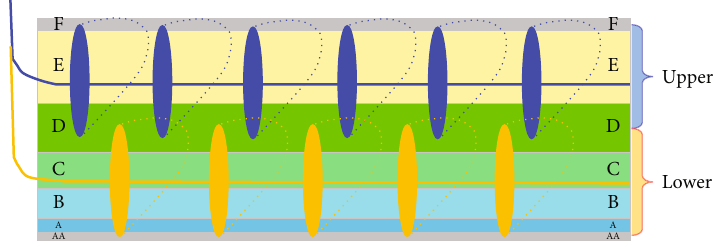
Figure 7: Sketch map of the two development layers in the Upper Montney Formation in the Groundbirch region.